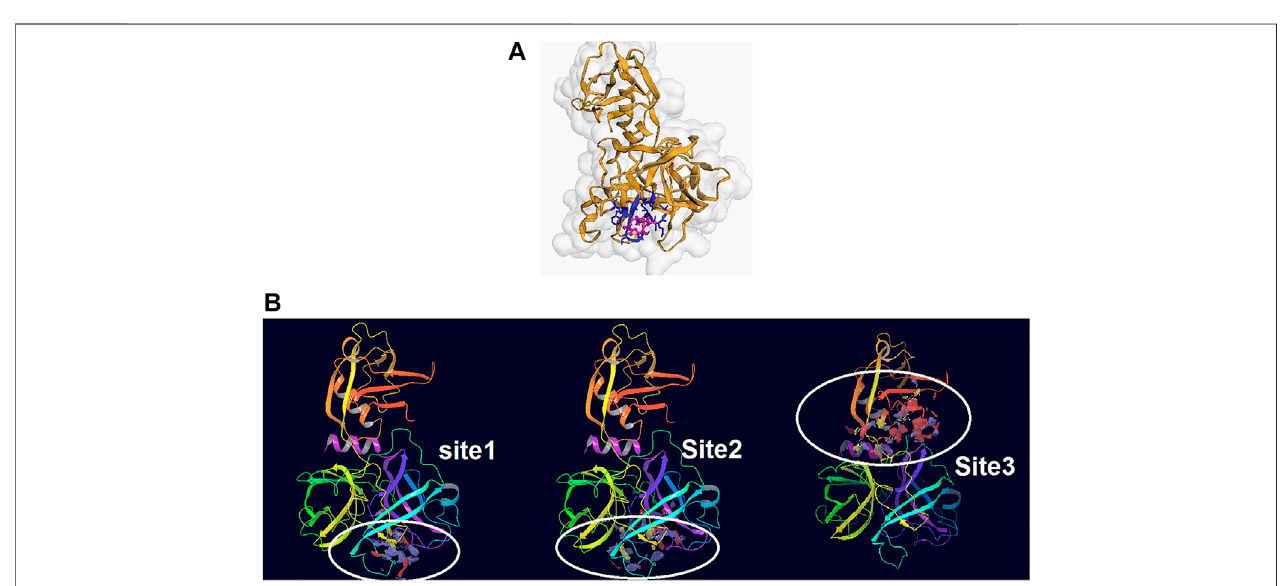
FIGURE 2 | (A) The predicted binding site by CPACH-D server. The protein template is a serine protease of the coagulation system (PDB: 5jb8) and ligand is [(4S, 5S)-4-[[2-[[(2S)-2-amino-4-carboxybutanoyl]amino]acetyl]amino]-6-chloro-5-hydroxyhexyl]-(diaminomethylidene)azanium with pubchem CID: 137347860. (B) The bindingsitespredictedbySitemap.Site1:Sitescore0.972,Dscore1.001,size87,andvolume150.Site2:Sitescore0.968,Dscore1.026,size91,andvolume228.Site 3: Sitescore 0.994, Dscore 1.044, size 108, and volume 331.